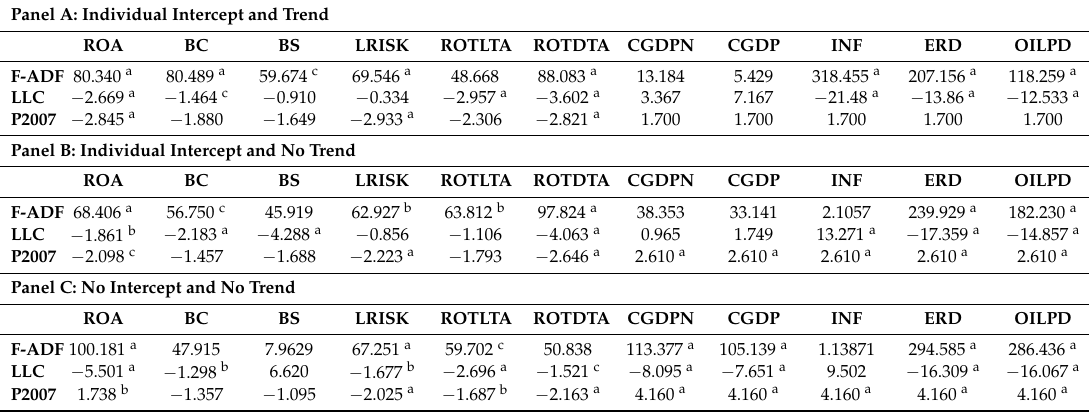
Table 4. Panel unit root test